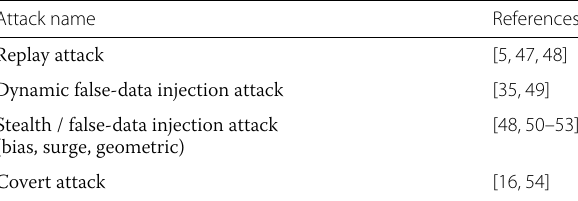
Table 5 Representative control-theoretic results on cyber-physical